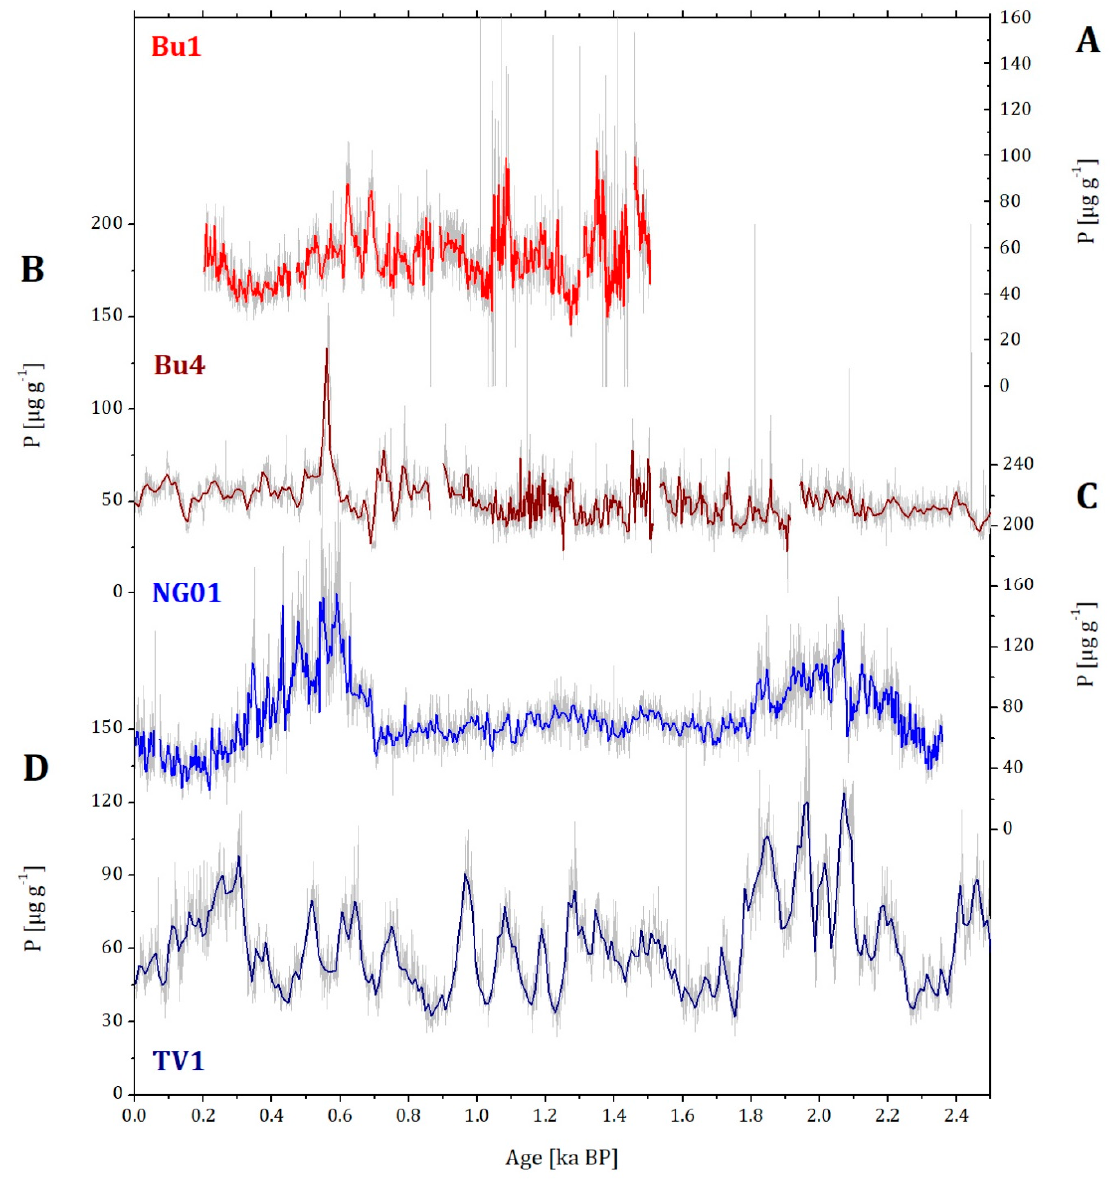
Figure 7. The P concentration of all four speleothems Bu1 ( A ), Bu4 ( B ), NG01 ( C ) and TV1 ( D ). The data were smoothed with a 10-point (NG01 and TV1) or 20-point (Bu1 and Bu4) running median. The raw data are shown in light grey and the running medians as colored lines.